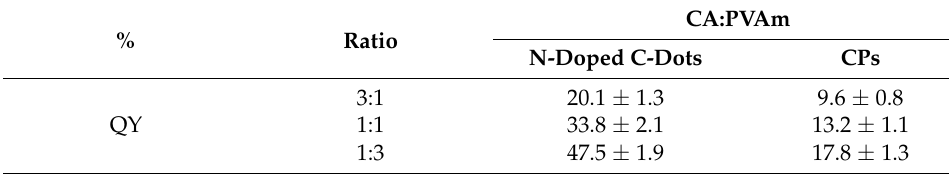
Table 2. The effect of size and nitrogen ratio on QY of N-doped C-dots and